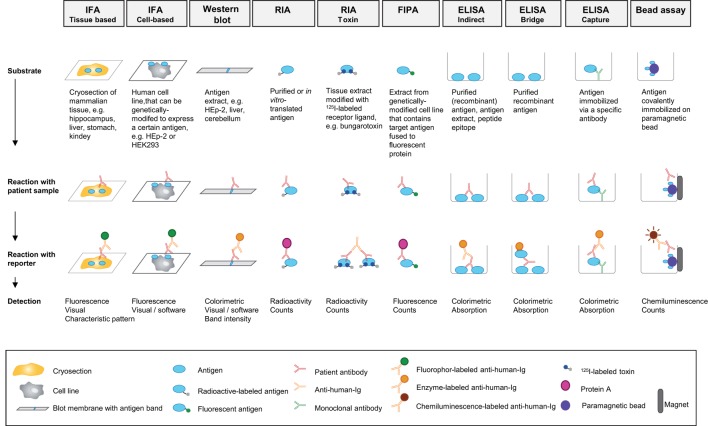
Detection of autoantibodies. Details are explained in the text. Abbreviations: ELISA, enzyme-linked immunosorbent assay; FIPA, fluorescence immunoprecipitation assay; IFA, indirect immunfluorescence assay; RIA, radioimmunoassay.